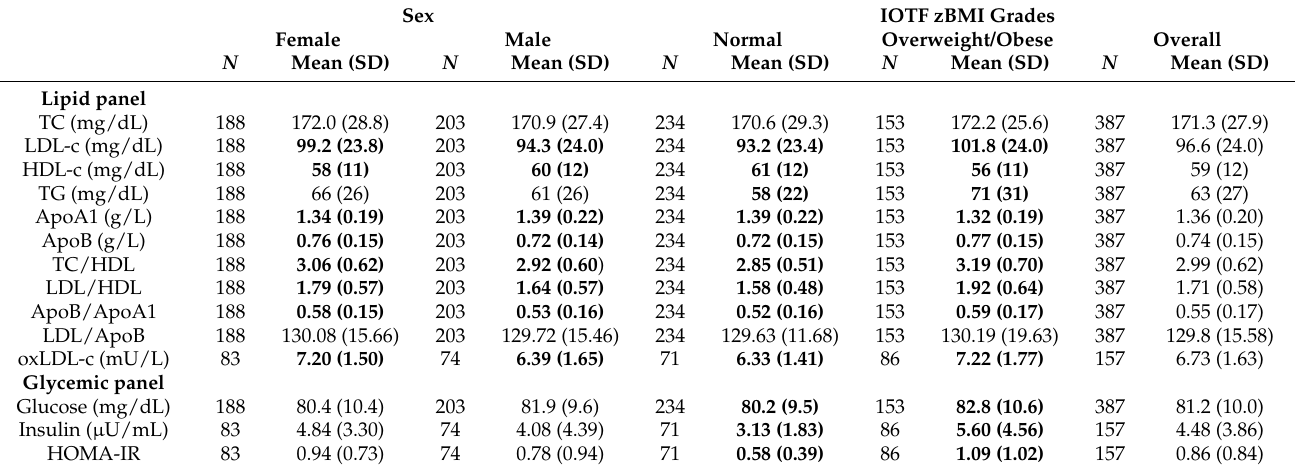
Table 2. Descriptive biochemical characteristics by sex and IOTF